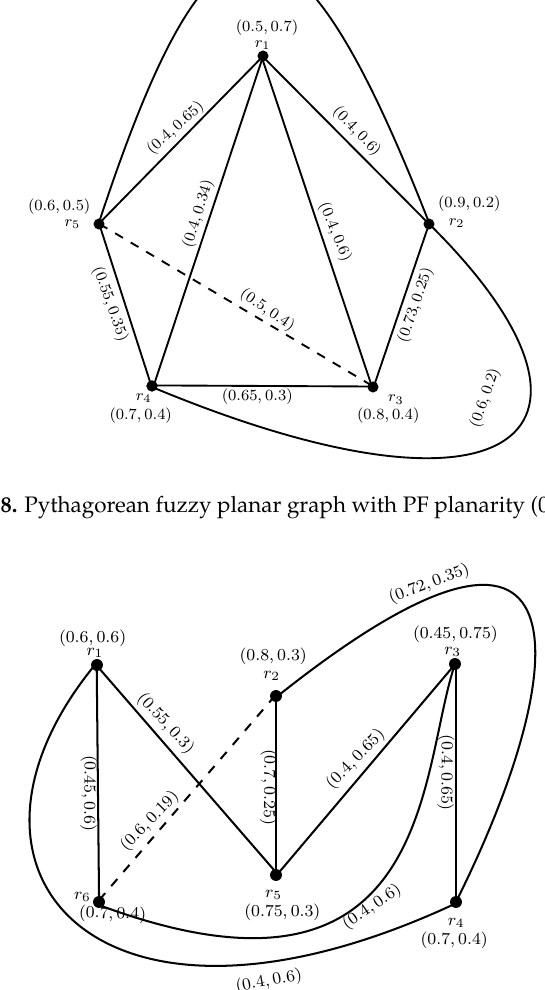
Figure 4.1: Pythagorean fuzzy planar graph with PF planarity (0.54,0.61)